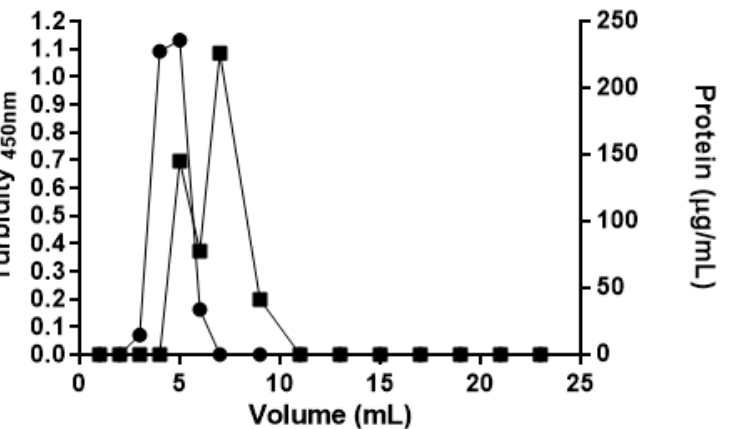
Figure 4. Sephadex G-200 column chromatography elution pattern of ASP-liposomes and non- encapsulated ASP. ( • ) Liposomes turbidity at 450 nm; ( ■ ) Protein concentration measured by Lowry method. The results presented are from one representative experiment, among the three independent experiments performed.